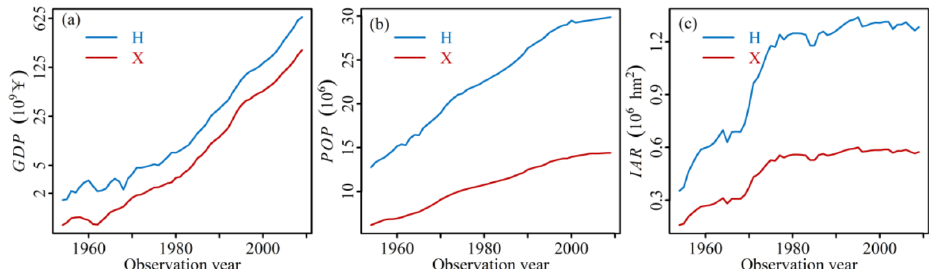
Figure 5. HA indices in both Huaxian (H) and Xianyang (X). (a) , (b) and (c) are for gross domestic production (GDP), population (POP) and irrigated area (IAR), respectively.